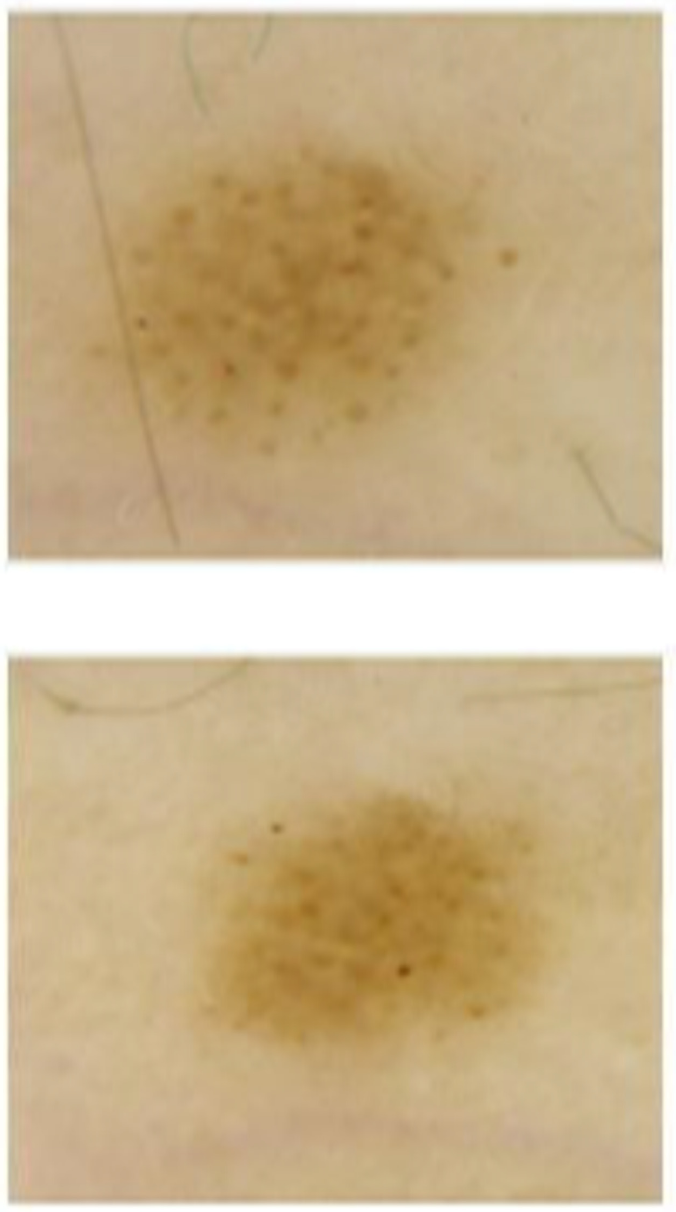
Figure 3. Example of nevi change in experimental group subject at T0 ( lower ) and T1 ( upper ). Expansion of diameters and presence of multiple pigmented globules over the lesion surface are signs of the physiological expansion of the mole.